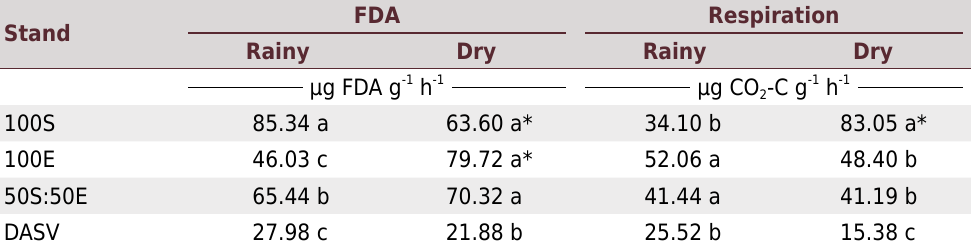
Table 2. Microbial activity of soil samples from degraded area with spontaneous vegetation (DASV) and degraded areas revegetated with Sesbania virgata and Eucalyptus camaldulensis in monospecific (100S and 100E, respectively) and mixed (50S: 50E) stands at 20 and 26 months after planting (rainy and dry seasons, respectively)